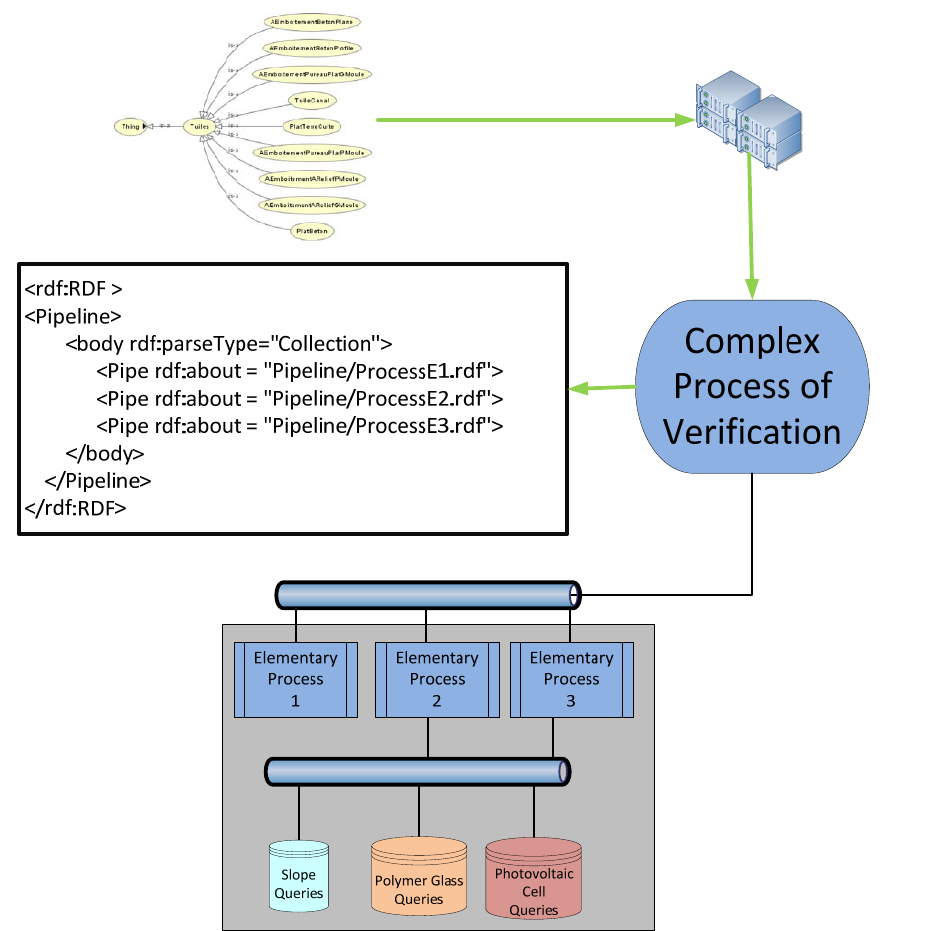
Figure 14. Complex process of checking